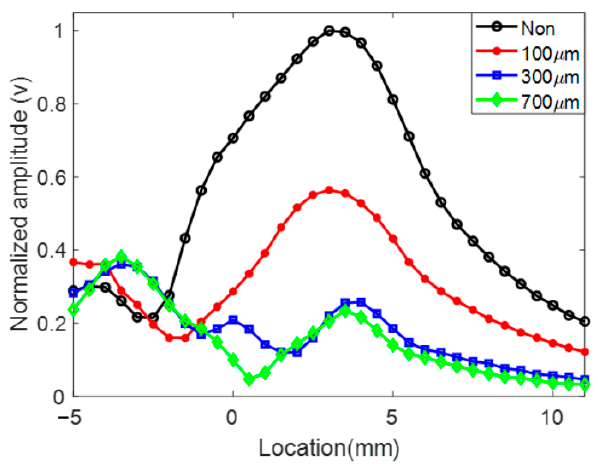
Figure 12. Experiment result of amplitude profiles of Shear defect type.